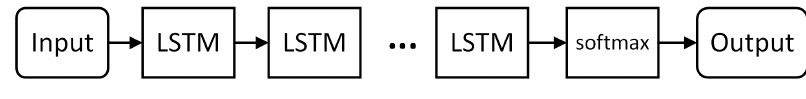
Figure 5. Workflow of crop classification.